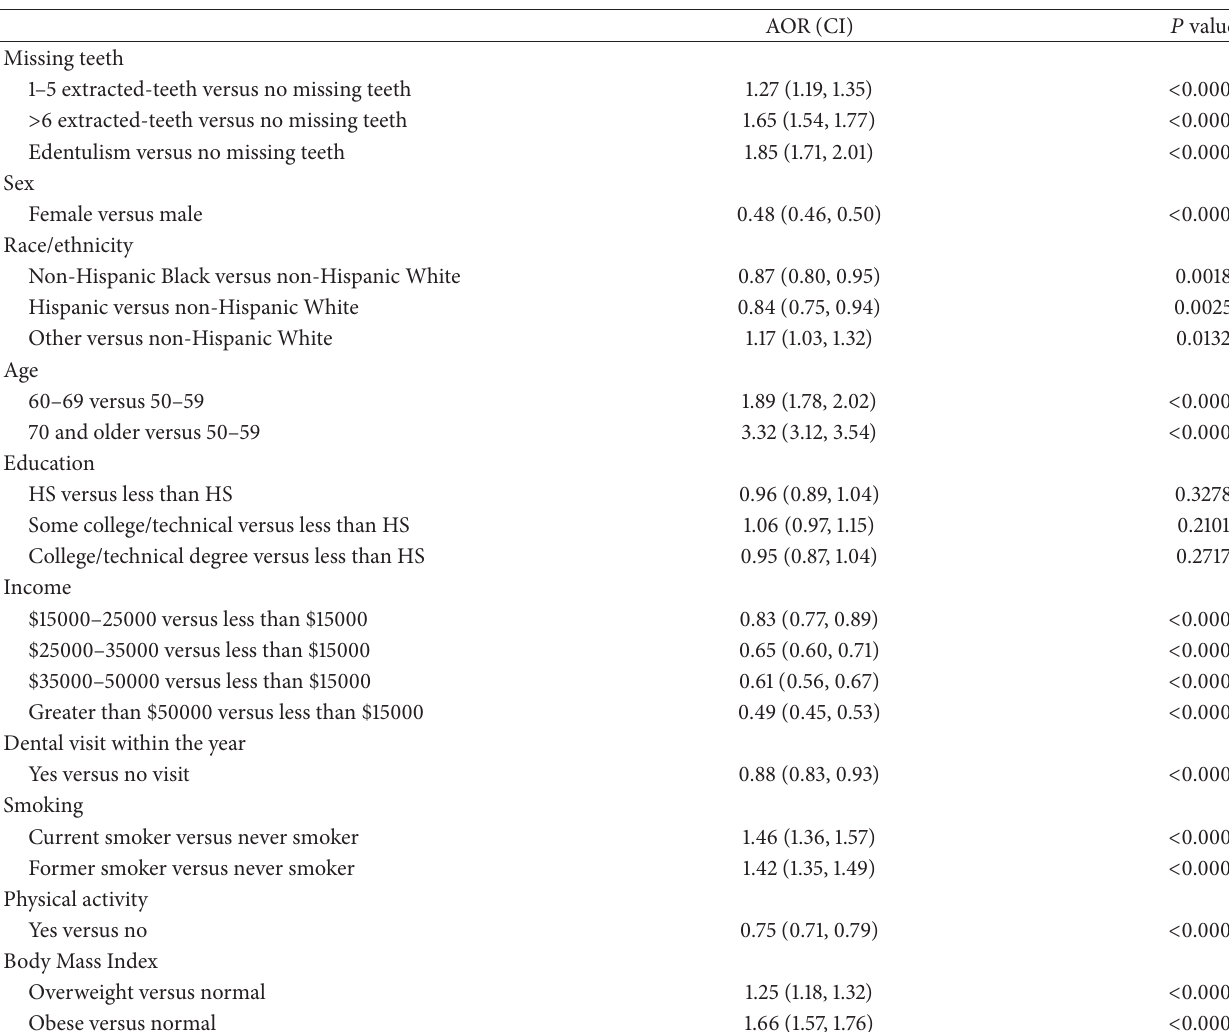
Table 2: Adjusted odds ratios (AOR) and the 95% confidence intervals according to cardiovascular diseases for the variables in the final logistic regression analysis behavioral risk factor surveillance system,